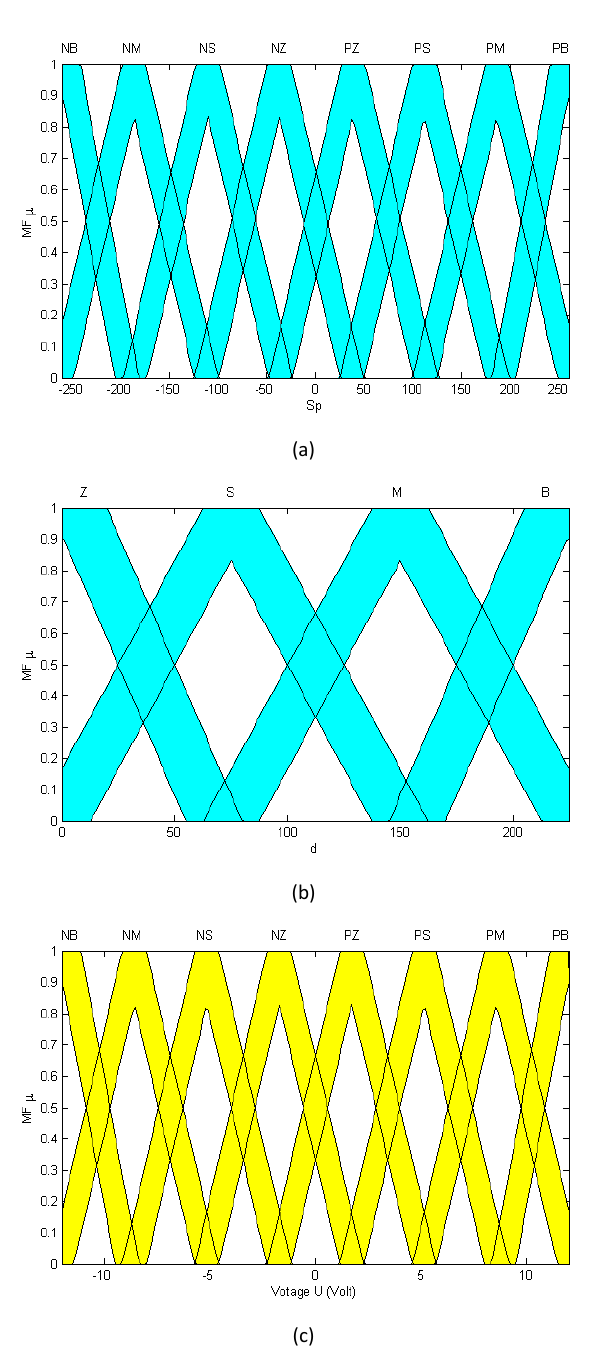
Fig. 2: T2FSMC with bisection algorithm